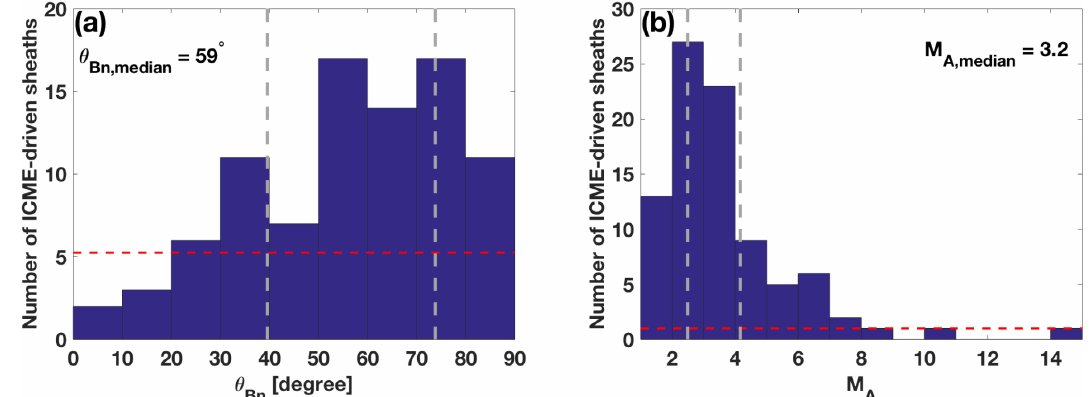
Figure 7. The frequency histograms of (a) preceding shock angle ( θ Bn ) in 10 ◦ bins and (b) Alfvén Mach number ( M A ) in bins of unity for investigated ICME-driven sheath regions. The grey dashed vertical lines divide both shock parameter distributions to quartiles. The red dashed horizontal lines indicate the lower quartiles according to the number of ICME-driven sheaths in each shock parameter interval.